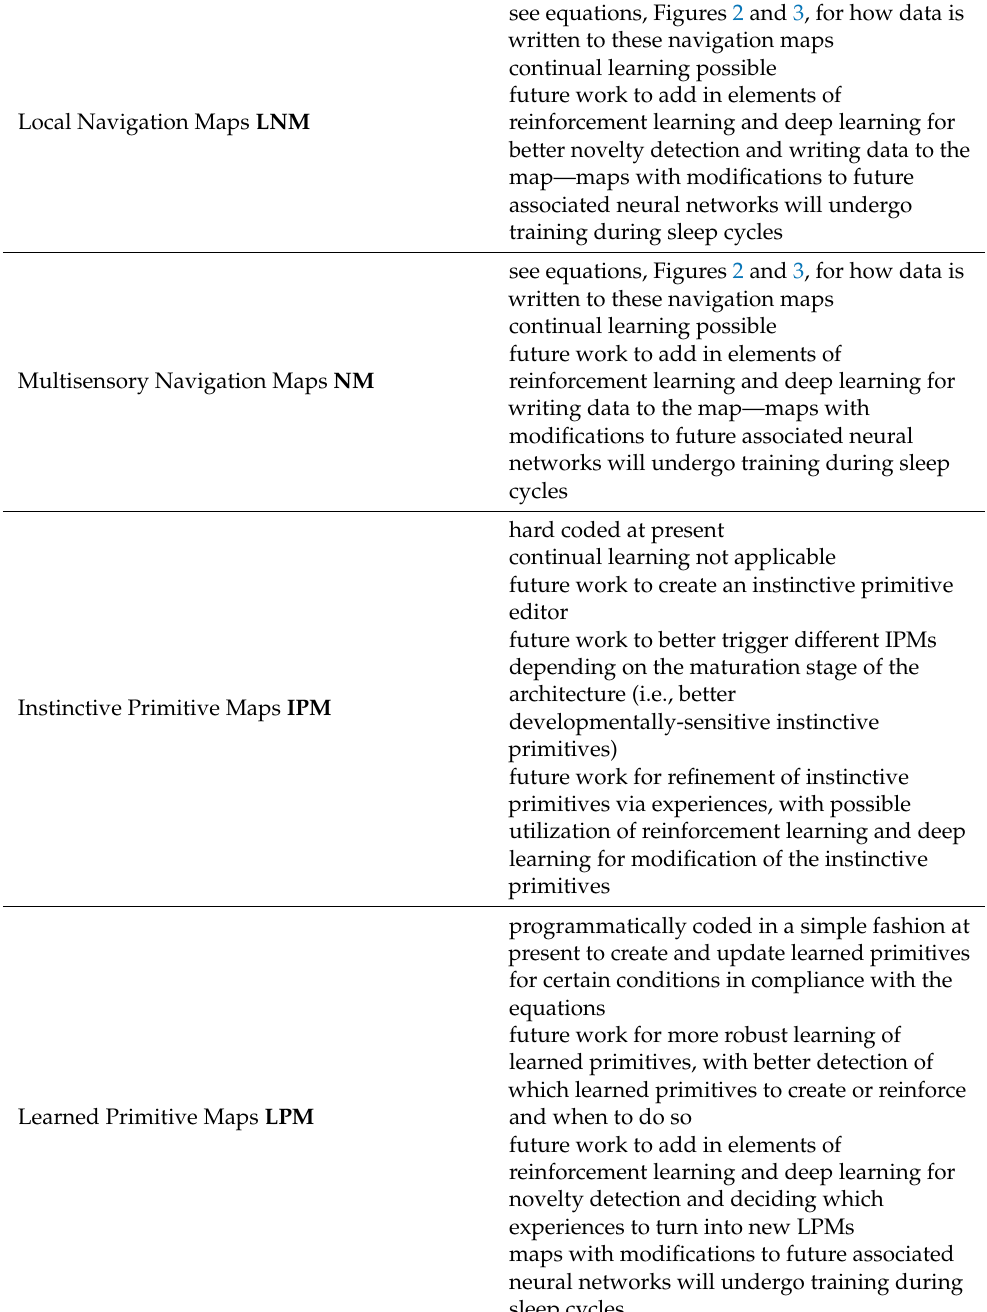
Table 1. Future work for learning algorithms to implement for the main navigation maps.